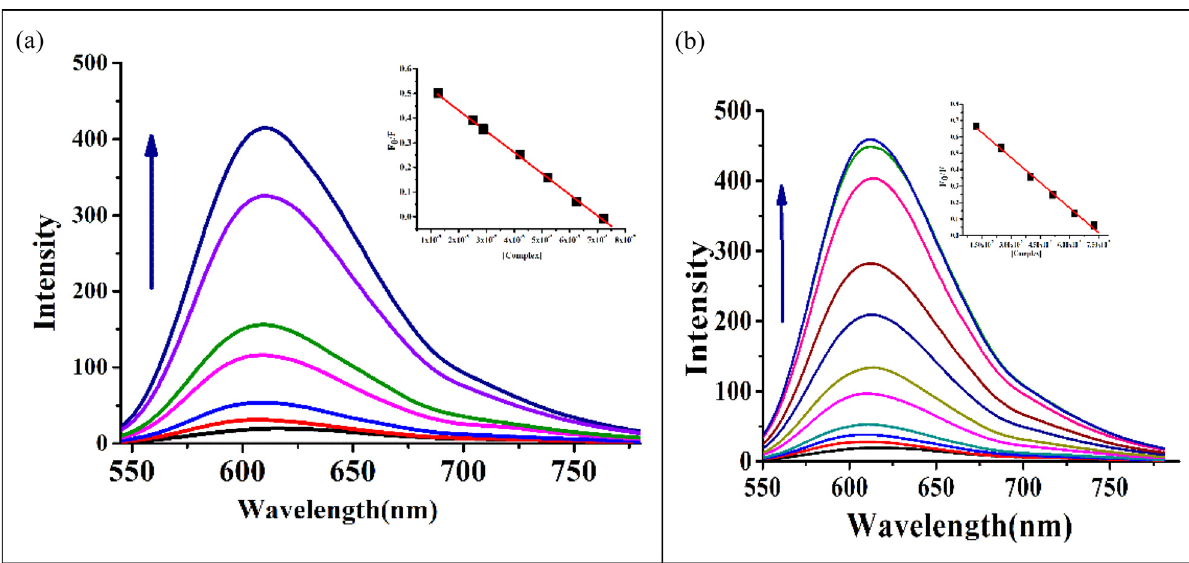
Figure 5: Emission spectra of EB bound to DNA where amounts of complexes CuL 1 was higher ( a ) and ( b ) emission spectra of EB bound to tRNA in the presence of increasing amount of complexes 1. Inset: Stern – Volmer plots ( Fo/F vs [ 1/2 ]) of fl uorescence titration.